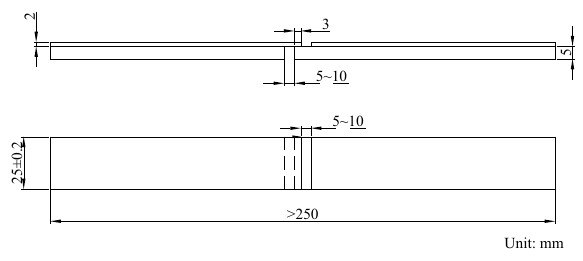
Figure 4. Dimensions of the tensile specimen.